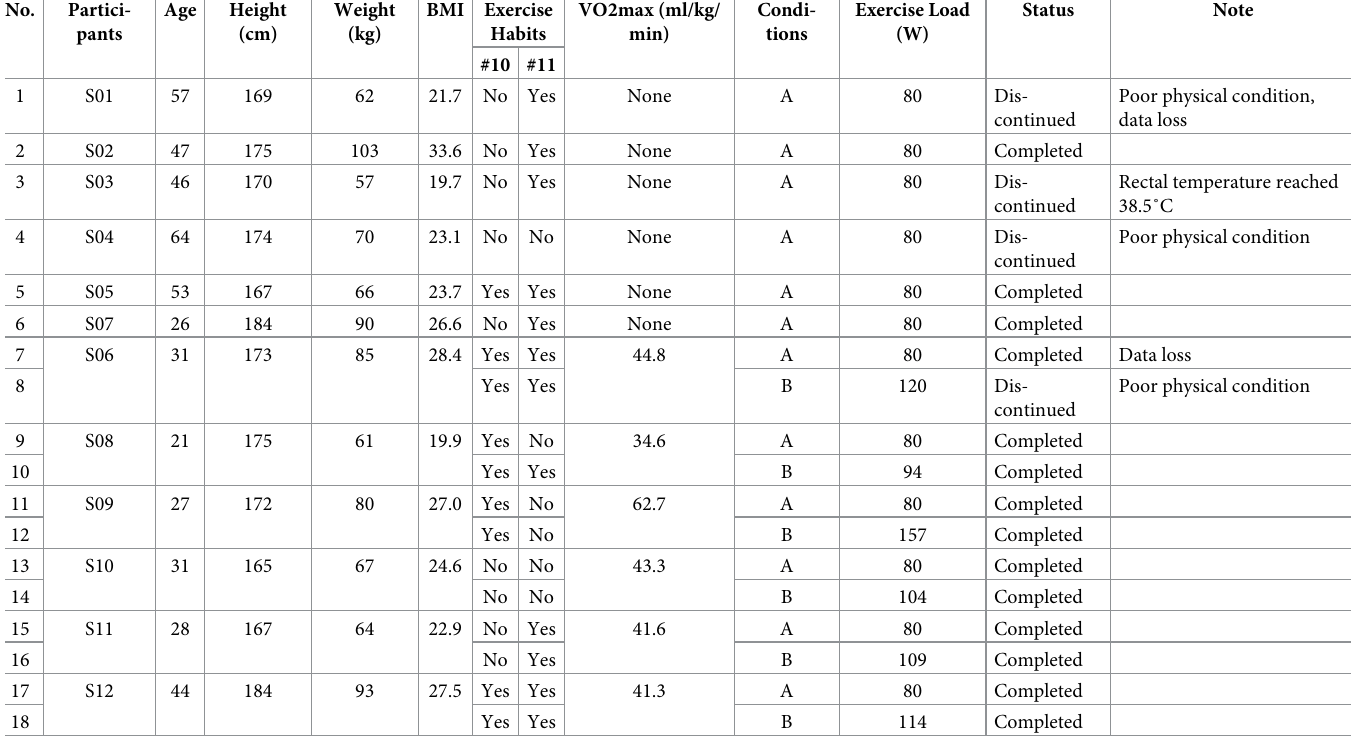
Table 1. Participants and environmental